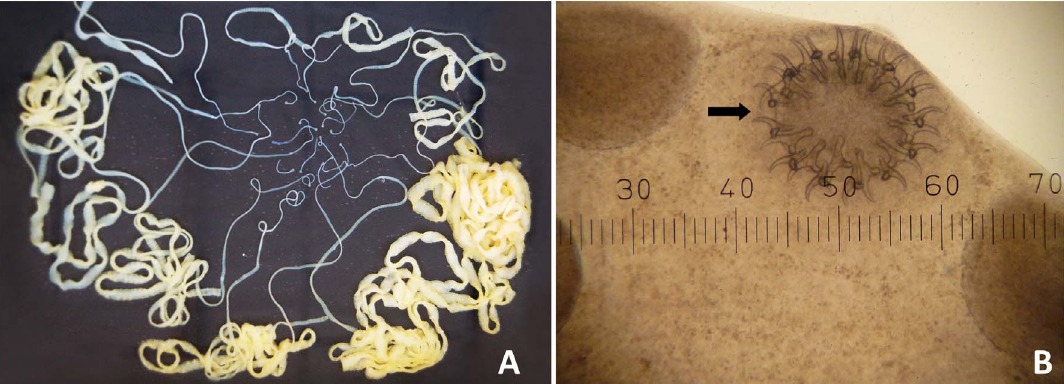
Figure 1. Nineteen Taenia solium tapeworms expelled from a 67-year-old Karen male patient (A). Macro-morphology of 19 tapeworms: Round scolices were observed in 19 worms. Morphology of the scolex of an intact worm (40 (cid:3) ): The scolex was characterized by two rows of hooklets (the black arrow referred) on the rostellum besides four suckers